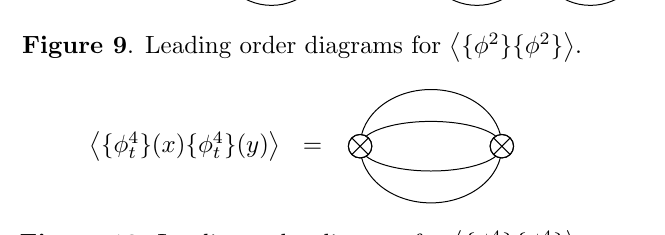
Figure 10 . Leading order diagram